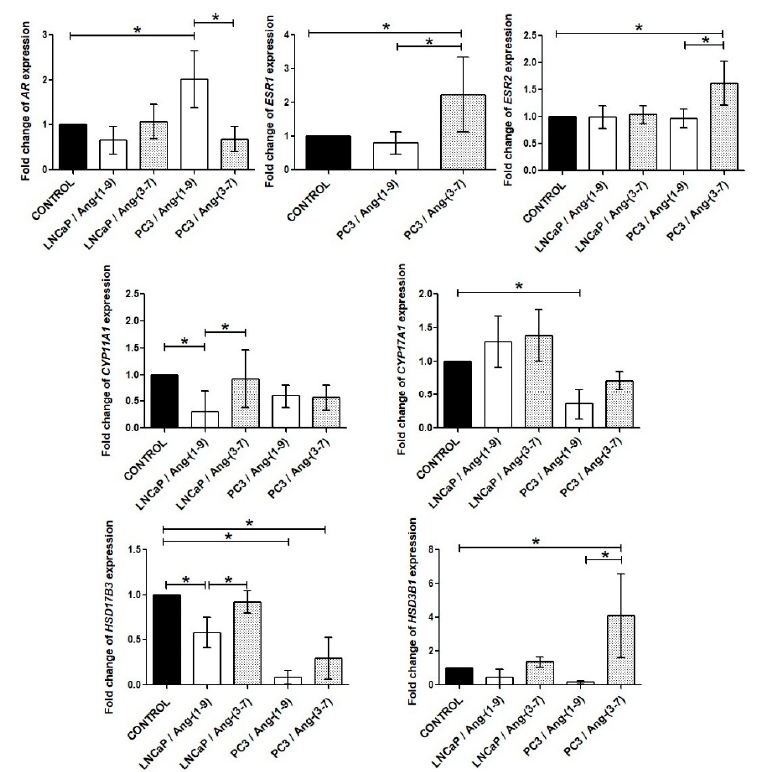
Figure 8. RT-qPCR analysis of steroidogenesis pathway gene expression in the prostate cancer lines (LNCaP and PC3) after exposure to Ang-(1-9) or Ang-(3-7) at a concentration of 1 nM for 48 h (mean ± SD; Tukey’s test: * p < 0.05).